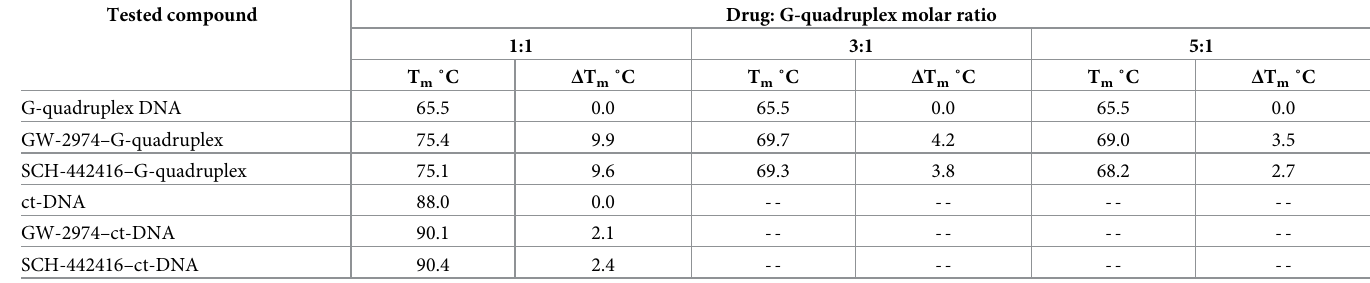
Table 2. Melting temperature of human telomeric G-quadruplex DNA and its GW-2974 and SCH-442416 complexes at different drug—DNA ratios. Δ T m measures the difference between T m ’s of the drug-DNA complex and pure